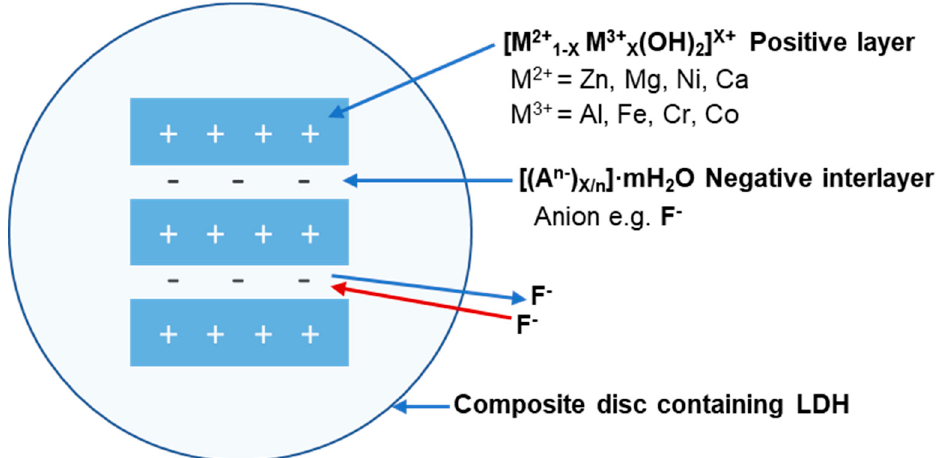
Figure 1. Schematic illustration of an enlarged LDH structure incorporated into, e.g., a composite material. The structure of the positive layer and negative interlayer displays fluoride absorption and release.